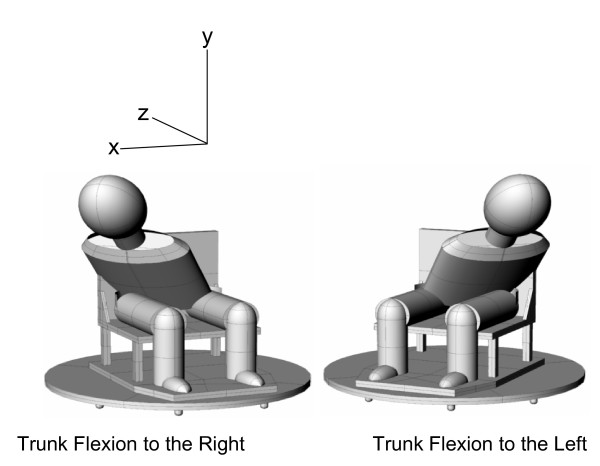
Illustration of the positioning of the subjects prior to frontal whiplash-type impacts.